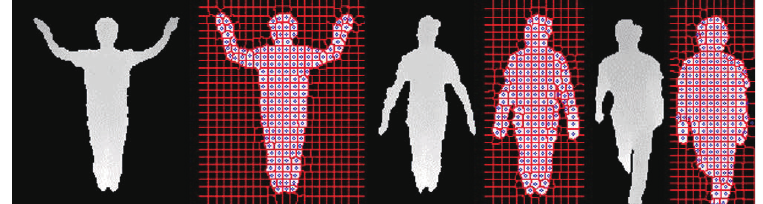
Figure 2. Results of superpixel generation on human bodies. The blue points on the human bodies are the generated